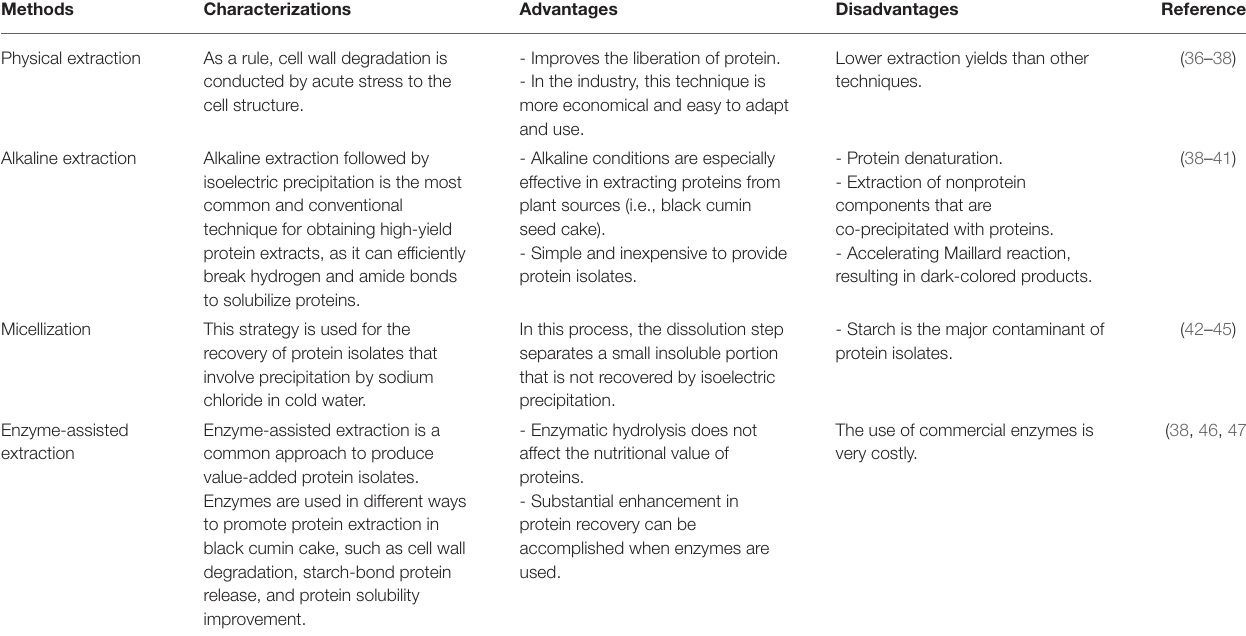
TABLE 2 | Advantages and disadvantages of standard methods used to extract proteins from black cumin seed